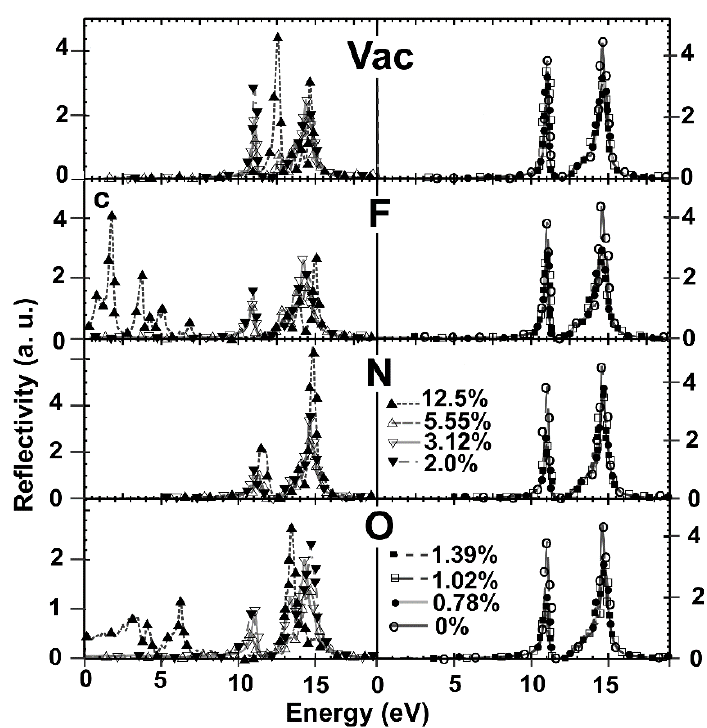
Figure 18. We show the reflectivity for different dopant (or vacancy) concentrations. For 0% (pristine graphene): O; for 0.78%: • ; for 1.02%: (cid:3) ; for 1.39%: (cid:4) ; For 2.0%: (cid:72) ; for 3.12%: (cid:53) ; for 5.55%: (cid:52) ; for 12.5%: (cid:78) . At the top, we have the reflectivity for different vacancy concentrations. At the bottom, we have the optical reflectivity for different oxygen percentages. As in the two previous cases, we show the reflectivity for fluorine and nitrogen for the same concentration variation in the middle. The horizontal axis marks the energy of incident electromagnetic radiation.